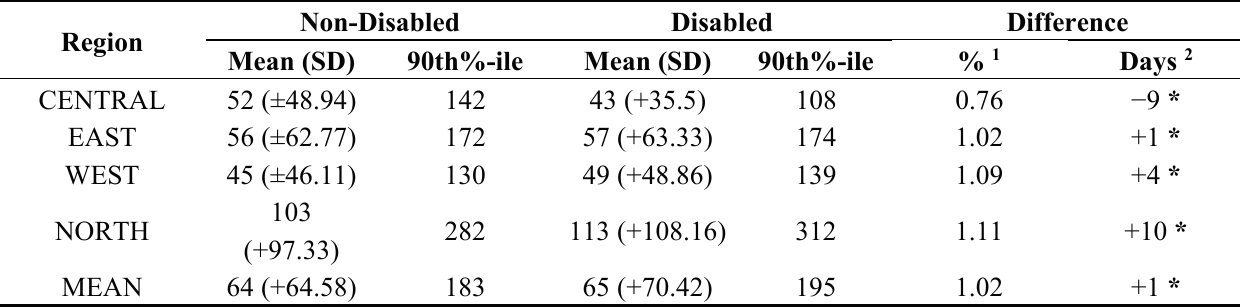
Table 2. Wait time to link disabled vs . non-disabled patients with family physicians. Non-Disabled Disabled Difference Region Mean (SD) 90th%-ile Mean (SD) 90th%-ile